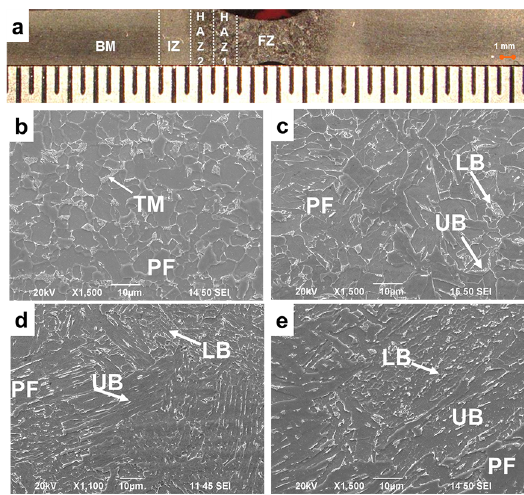
Figure 2. SEM micrographs showing resultant phases of the AHSS DP600 in various weld regions. (a) Overall view, (b) IZ, (c) HAZ 2, (d) HAZ 1 and (e) FZ.